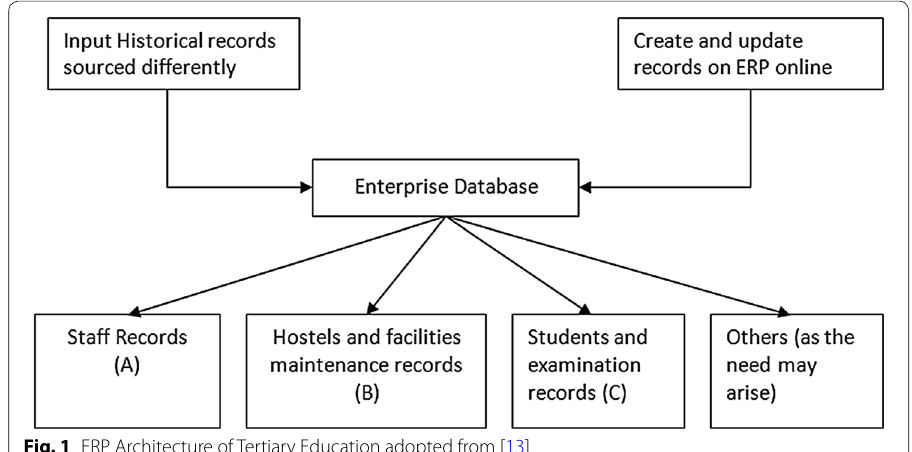
Fig. 1 ERP Architecture of Tertiary Education adopted from [13]